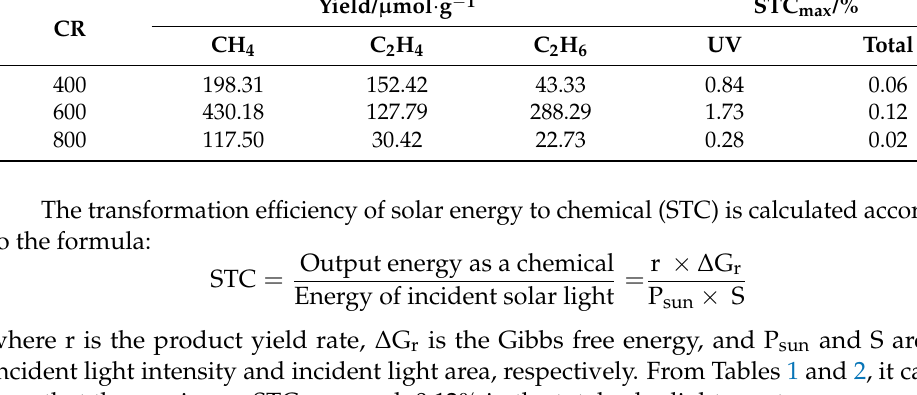
Table 2. STC max efficiencies of Bi 2 WO 6 /WO 3 under concentrating solar light.